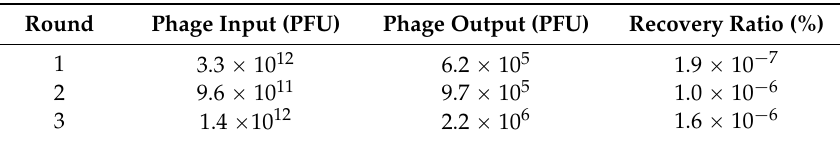
Table 4. Selective enrichment of anti-ricin phage displayed antibodies from the libraries during panning.